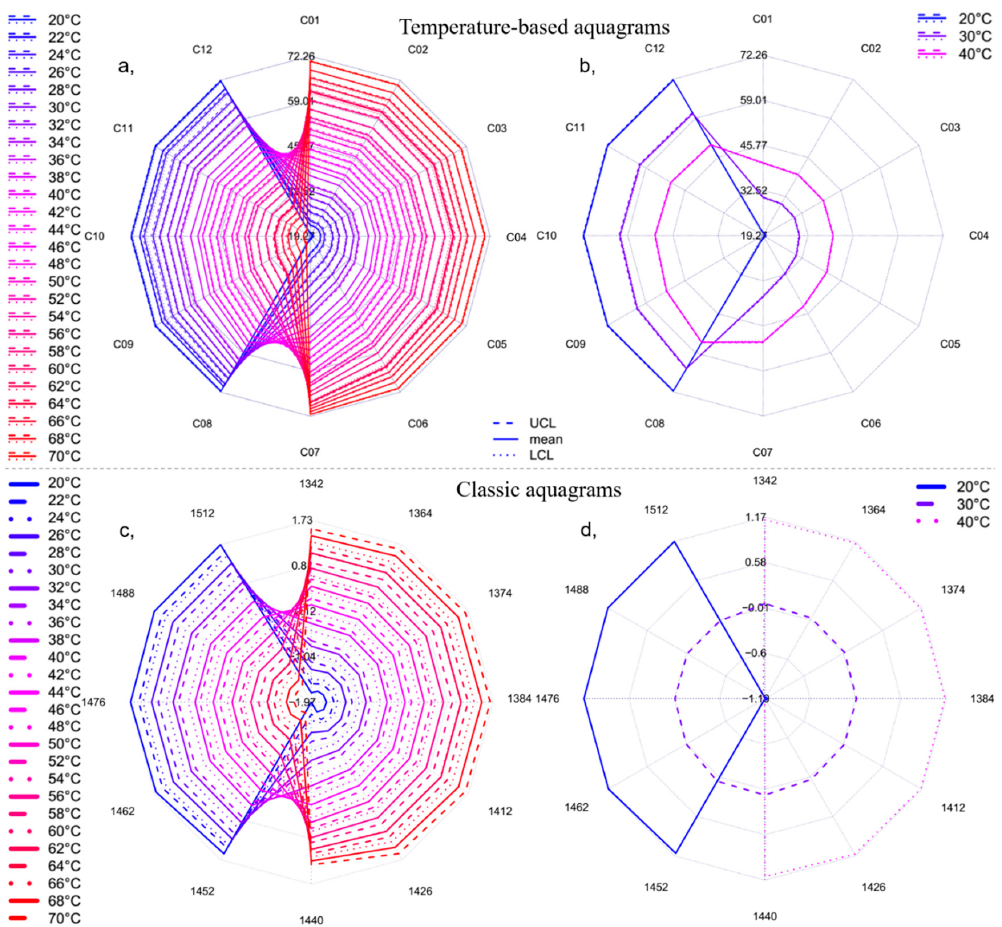
Figure 3. Aquagrams of Milli-Q water in the temperature range of 20–70 ◦ C, ( a , b ) with 95% confidence intervals calculated with temperature-based aquagram calculation method, ( c , d ) calculated with the classic calculation method, ( a , c ) all the 26 temperature steps ( n = 78) and ( b , d ) on three selected temperature steps ( n = 9) to show the stability of the methods (UCL—upper confidence level, LCL—lower confidence level).